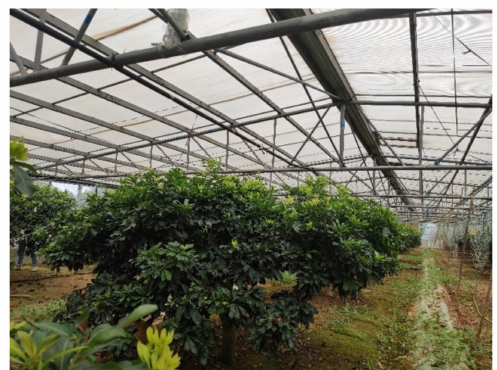
Figure 1. Bayberries cultivated in